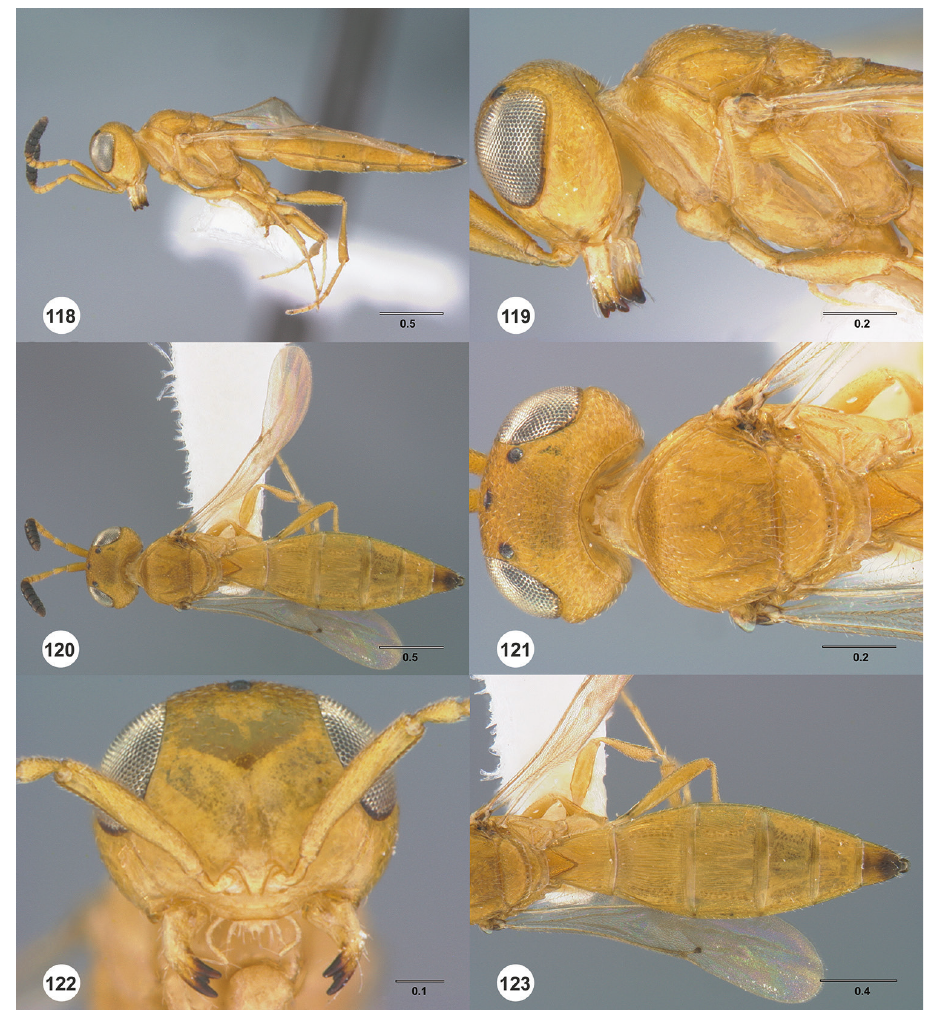
Figures 118–123. Calliscelio gatineau sp. n., female, holotype (OSUC 534340). 118 Lateral habi- tus 119 Head and mesosoma, lateral view 120 Dorsal habitus 121 Head and mesosoma, dorsal view 122 Head, anterior view 123 Metasoma, dorsal view. Scale bars in millimeters. Calliscelio glaber Chen & Masner, sp.